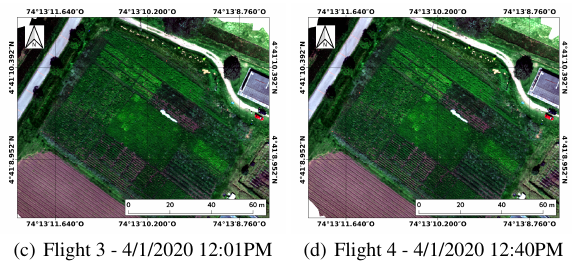
Figure 9. Results - Orthomosaics